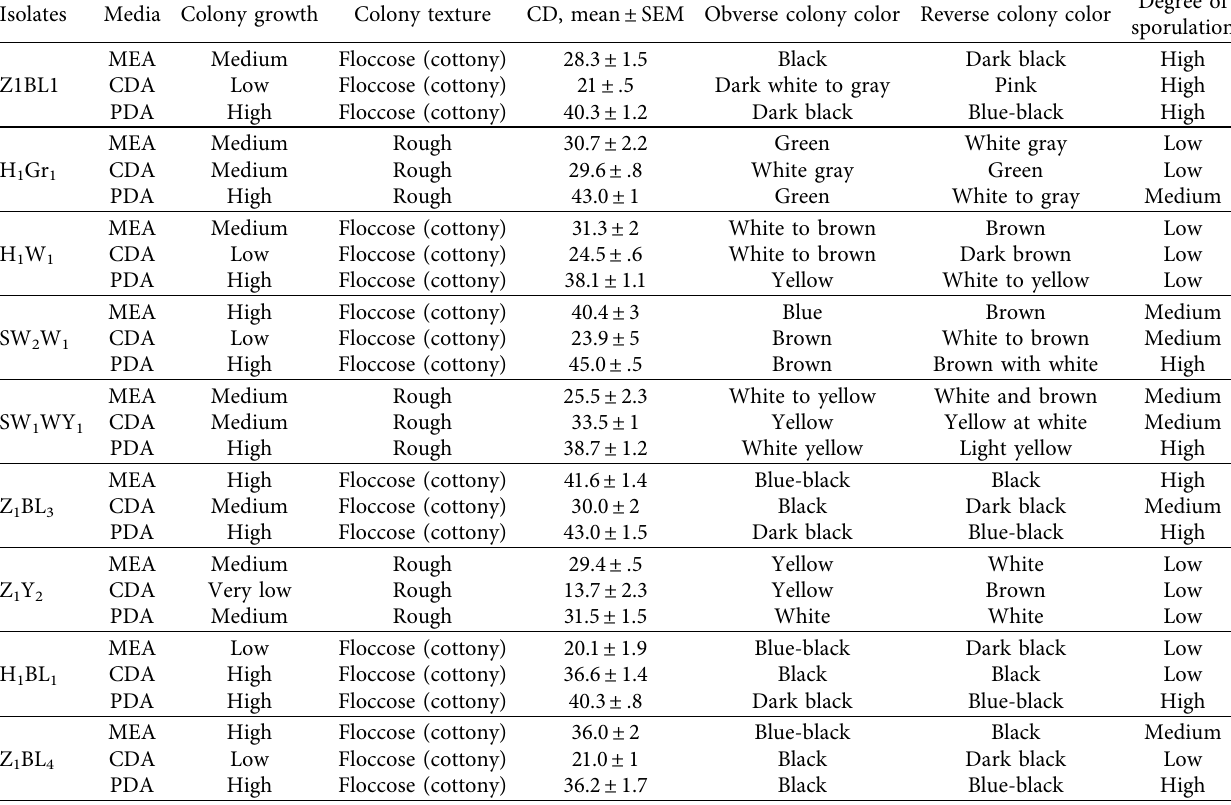
Table 3: Macroscopic characteristics of potential fungal